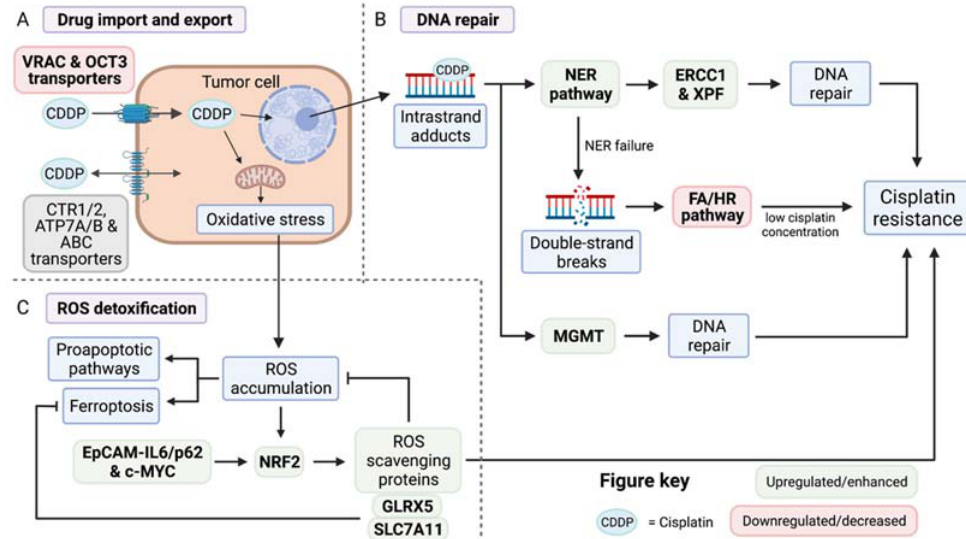
Figure 1. Classical mechanisms of cisplatin resistance in HNSCC. ( A ) Alterations in cellular import and export of cisplatin. Downregulation of VRAC and OCT3 transporters reduces cisplatin cytotoxi- city by decreasing its intracellular concentration. While CTR1/2, ATP7A/B and ABC transporters are promising candidates in cisplatin resistance, their functional role in HNSCC is still unknown. ( B ) Activation of DNA repair pathways. Upregulation of NER pathway components ERCC1 and XPF, enhances the removal of DNA intra-strand adducts caused by cisplatin. If NER fails, it will